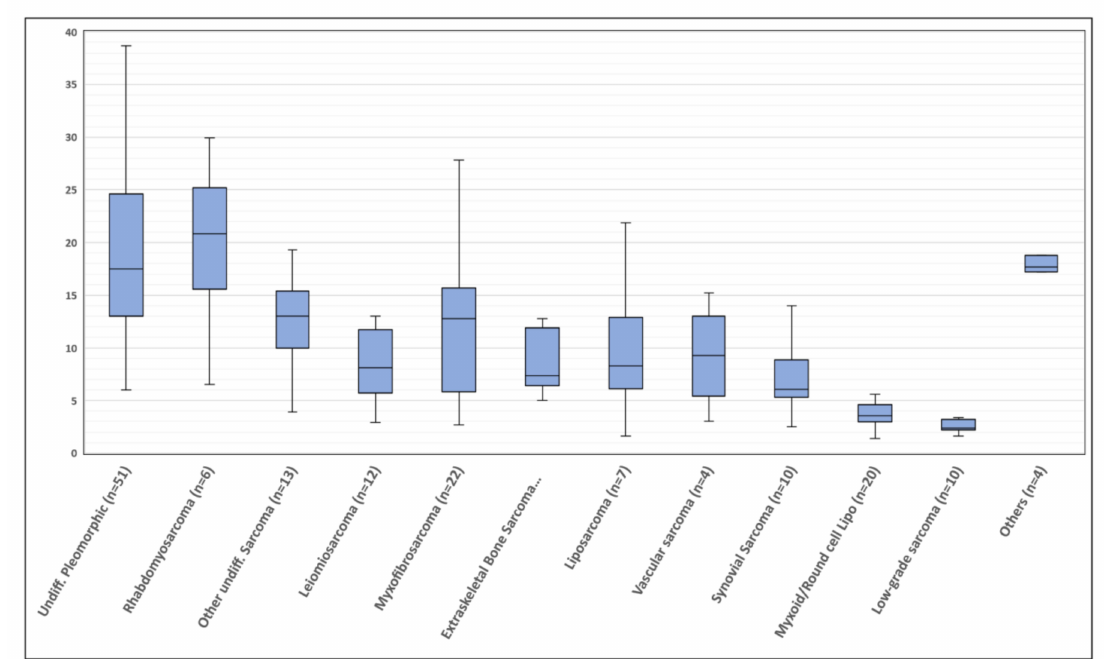
Figure 1. Distribution of standardized uptake value (SUV max ) values in 18 F-fluorodeoxyglucose positron emission / computed tomography ( 18 F-FDG PET / CT) performed in the initial staging, according to di ff erent histological subtypes. Boxplot shows interquartile range (box), median (line within the box) and data range (vertical lines). “ Low-grade sarcoma ” includes: myxoinflammatory fibroblastic